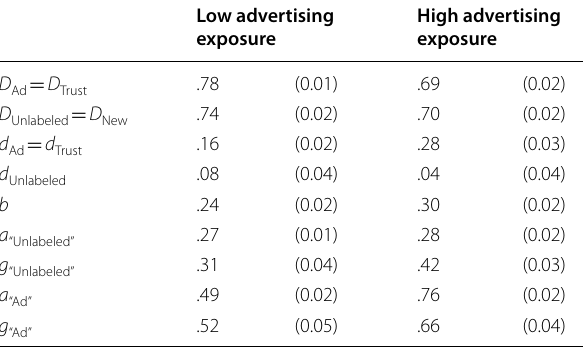
Table 2 Parameter estimates for statement recognition, source memory, and guessing as a function of advertising exposure (low, high) in Experiment